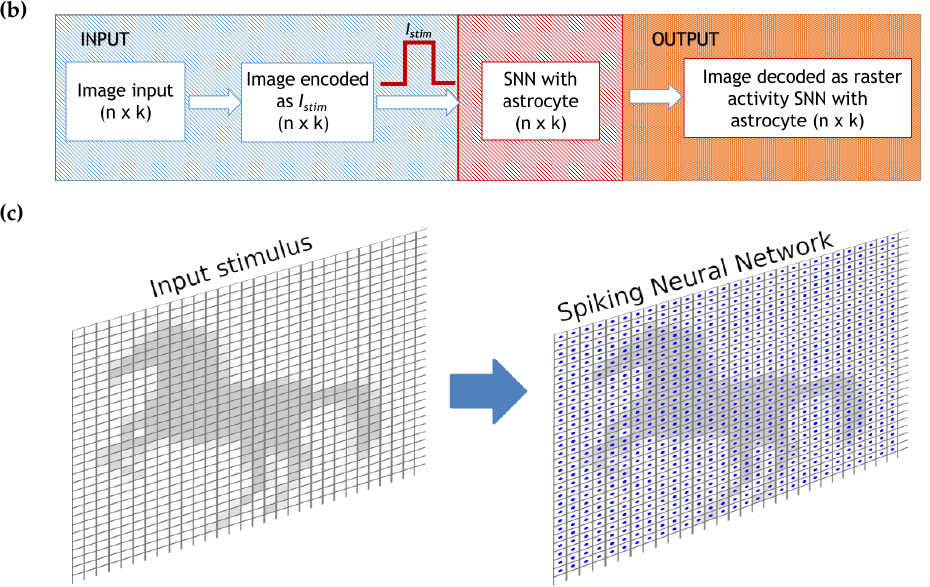
Figure 1. ( a ) Scheme of neuron–astrocyte network. ( b ) Scheme of encoded and decoded image input in spiking neural network with astrocyte regulation. ( c ) Schematic view of an input image load into the spiking neural network. Neurons (the blue dots) are arranged as two-dimensional lattice directly corresponding to image’s